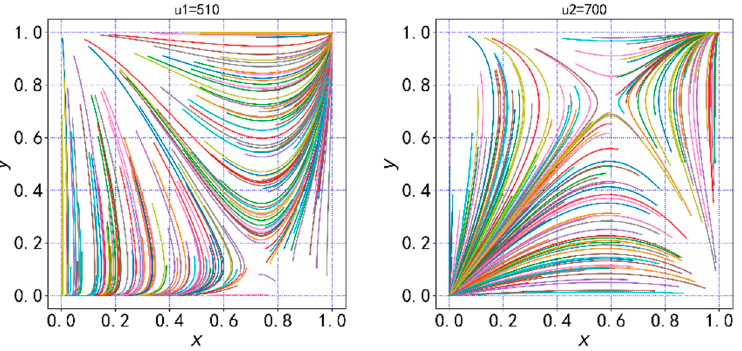
Figure 8. Simulation results chart for (cid:1873) (cid:2869) =510 (cid:1873) (cid:2870) = 700 .